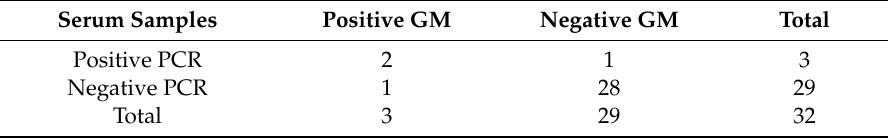
Table 5. Concordance of 28S PCR and galactomannan (GM) in serum samples ( n =